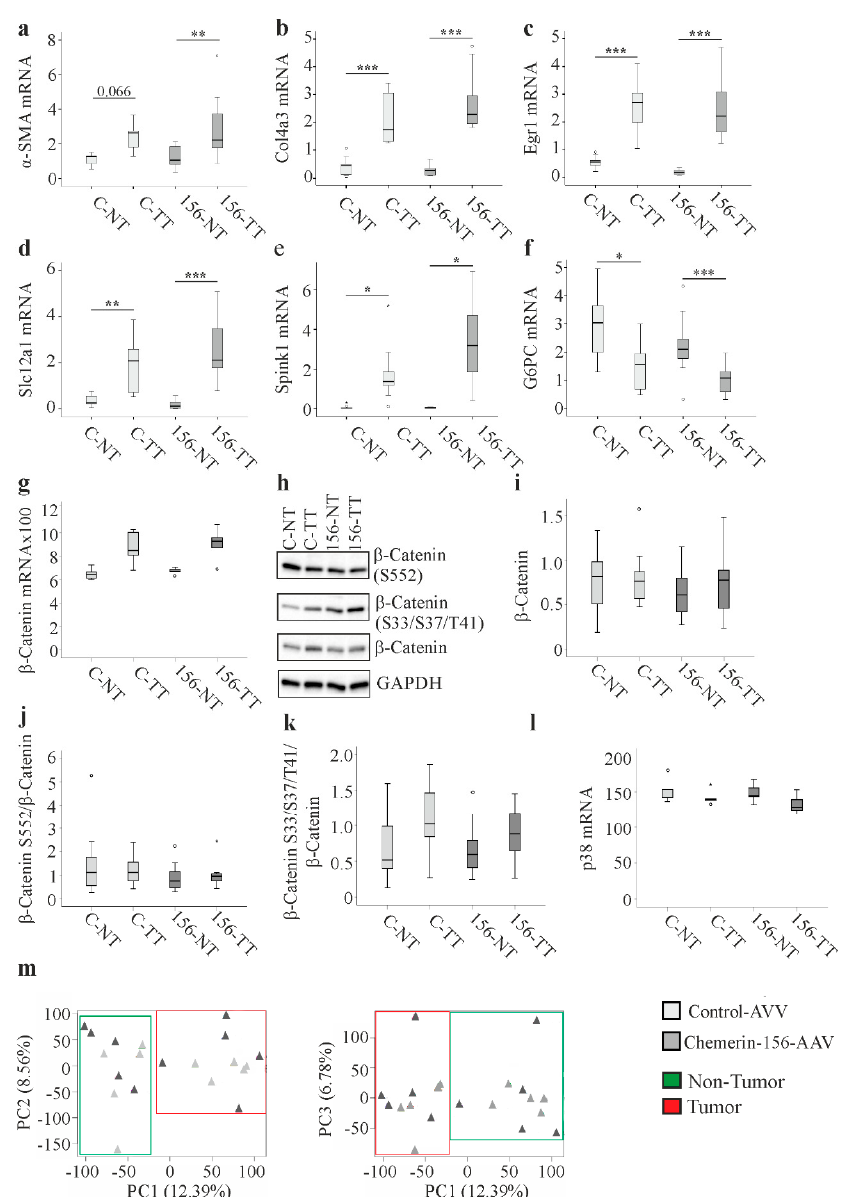
Figure 4. Principle component analysis of microarray data, and the expression of di ff erent genes and β -catenin proteins in hepatic non-tumorous (NT) and tumor tissue (TT) of control-AAV and chemerin-156-AAV infected mice. Data shown in g and l were obtained from GeneChip analysis, the expression of further genes was analyzed by real-time reverse-transcription polymerase chain reaction (RT-PCR). Expression of ( a ) α SMA (the number in the figure is the p -value for an almost significant difference). ( b ) Col4a3 . ( c ) Egr1 . ( d ) Slc12a1 . ( e ) Spink1 , and ( f ) G6PC mRNA. ( g ) β -catenin mRNA. ( h ) β -catenin and its phosphorylated forms. ( i ) Quantification of β -catenin protein. GAPDH was used for normalization. ( j ) Quantification of β -catenin protein phosphorylated at S552. Unphosphorylated β -catenin was used for normalization. ( k ) Quantification of β -catenin protein phosphorylated at S33, S37, or T41. Unphosphorylated β -catenin was used for normalization. ( l ) Expression of p38 mRNA. ( m ) Principle component analysis of the microarray experiment where tumorous and non-tumorous tissues of control and chemerin-156-AAV infected mice were analyzed ( n = 5 per group). Small circles in the figure indicate outliers greater than 1.5 times the interquartile range and small stars indicate outliers greater than 3.0 times the interquartile range. * p < 0.05, ** p < 0.01, *** p <